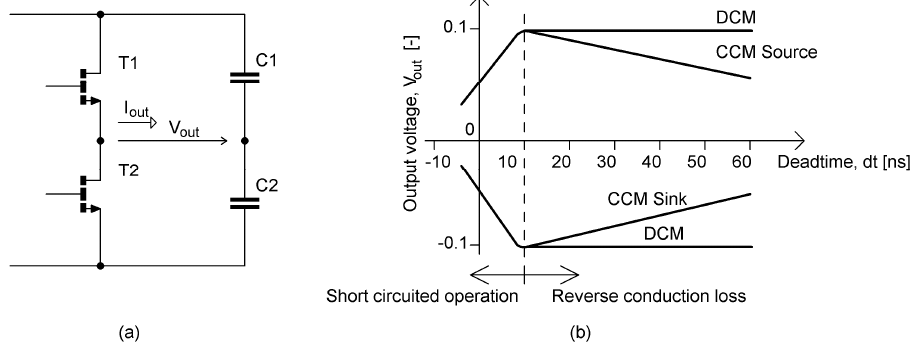
Figure 4. Output voltage dependence on dead-time: ( a ) virtual DC-link neutral point, ( b ) dependence of output voltage on dead-time and modes of operation.